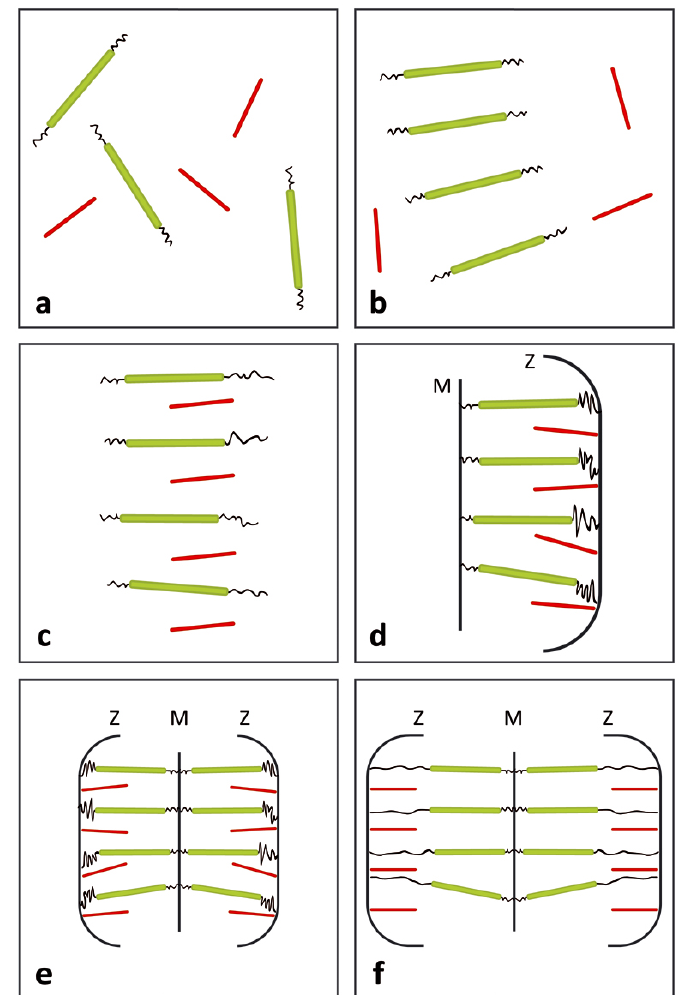
Figure 2. Suggested sequence of assembly steps during the formation of individual sarcomeres. Color code as in Figure 1. ( a ) The first stage is regarded as a cell hosting a single-phase isotropic solution with volume fractions of the thick and thin filaments below their corresponding critical values v c . ( b ) Upon increasing filament production, the critical value of the thick filament is attained and the cell hosts a biphasic dispersion including the liquid crystalline phase of the latter filament separated from the isotropic phase of the thin one. ( c ) Upon further increase of filament production, the critical concentration will be attained also by the thin one. Under an excess of Ca ++ ions, both filaments are electrostatic ally screened and able to form a single mesophase. ( d ) Anchoring of the two types of filaments to opposite sides of the cell defines the remodeling Z-zone and M line in which the exact spacing between the two filaments is eventually imprinted. ( e ) Specular coupling of two half-sarcomers at the M line produces a full sarcomer. ( f ) Pumping Ca ++ ions out of the sarcomer produces reversible elongation of the cell manifested by separation of the thick and thin filaments and elongation of elastic titin segments.